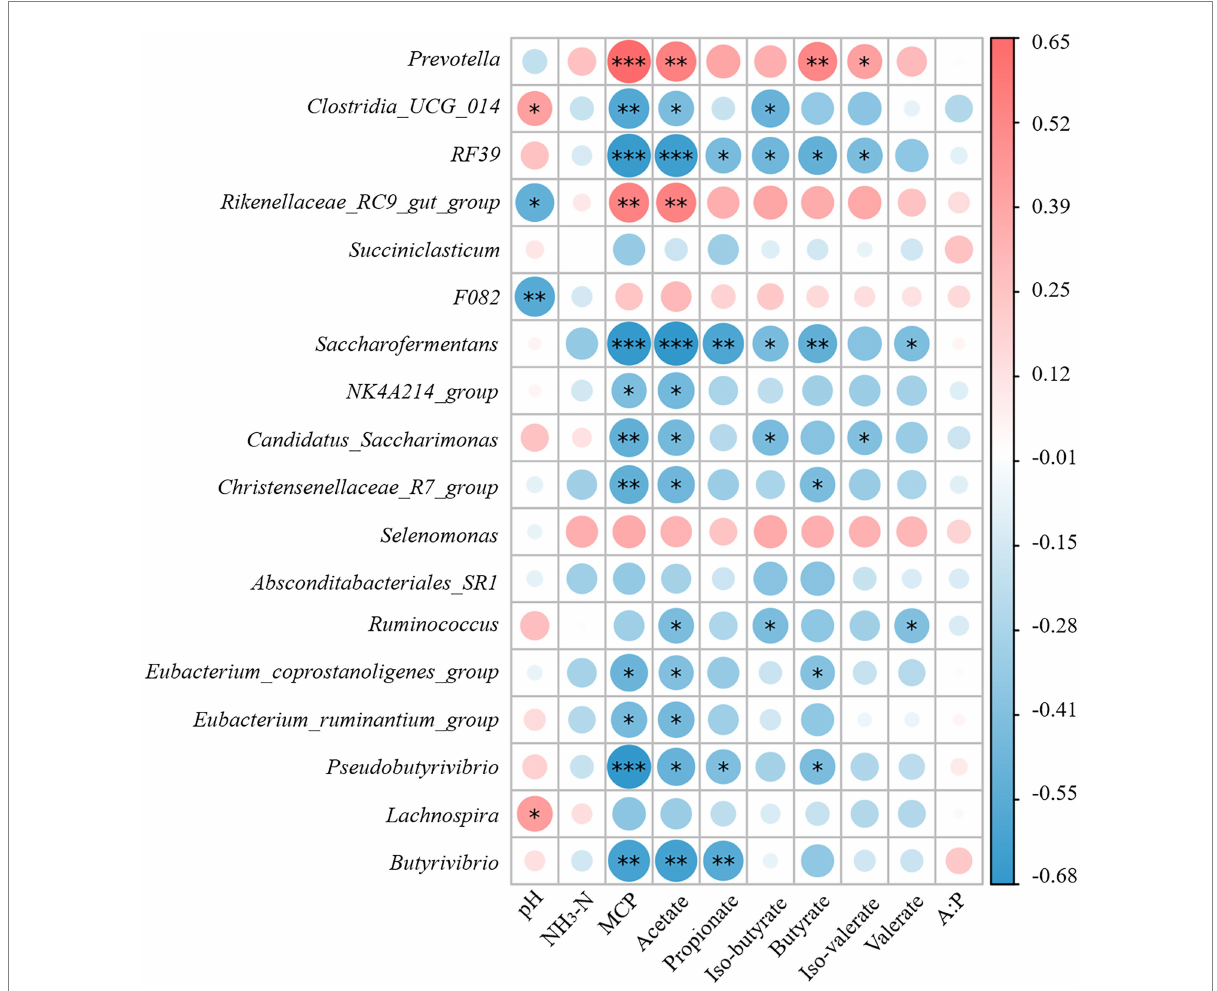
FIGURE 5 Spearman correlation between rumen fermentation indicators and bacterial populations. The area of the circle indicates the magnitude of the correlation, and the different colors indicate positive correlation (red) or negative correlation (blue). * indicates 0.01 < p ≤ 0.05, ** indicates p ≤ 0.01 and *** indicates p ≤